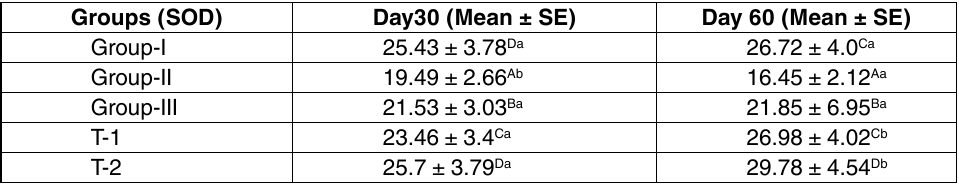
table 10. The mean ± SE SOD activity(U/mg protein) in liver tissue collected from rats under different treatment